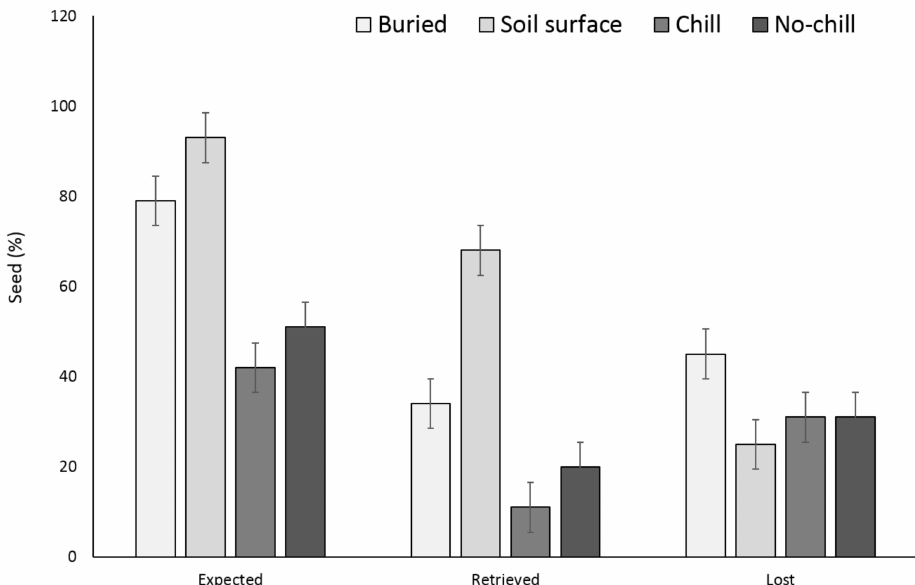
Figure 8. Effect of environmental conditions on S. obtusifolia seed loss originating from a multiple maternal source after two years. Vertical bars represent LSD at 5% significance level. Expected” is the sum of non-germinated